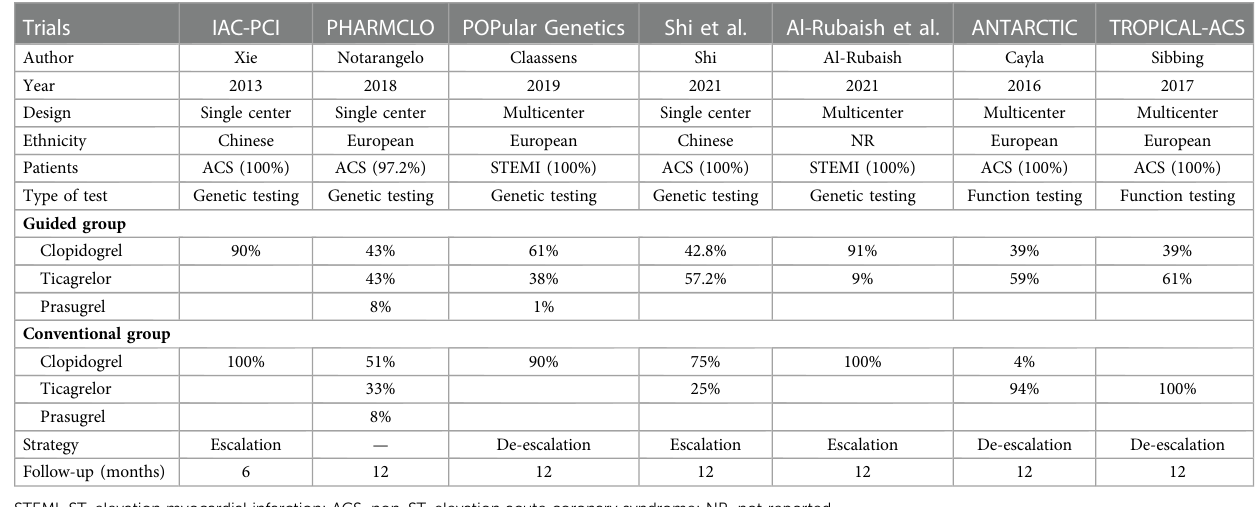
TABLE 1 Baseline characteristics of the included trials.